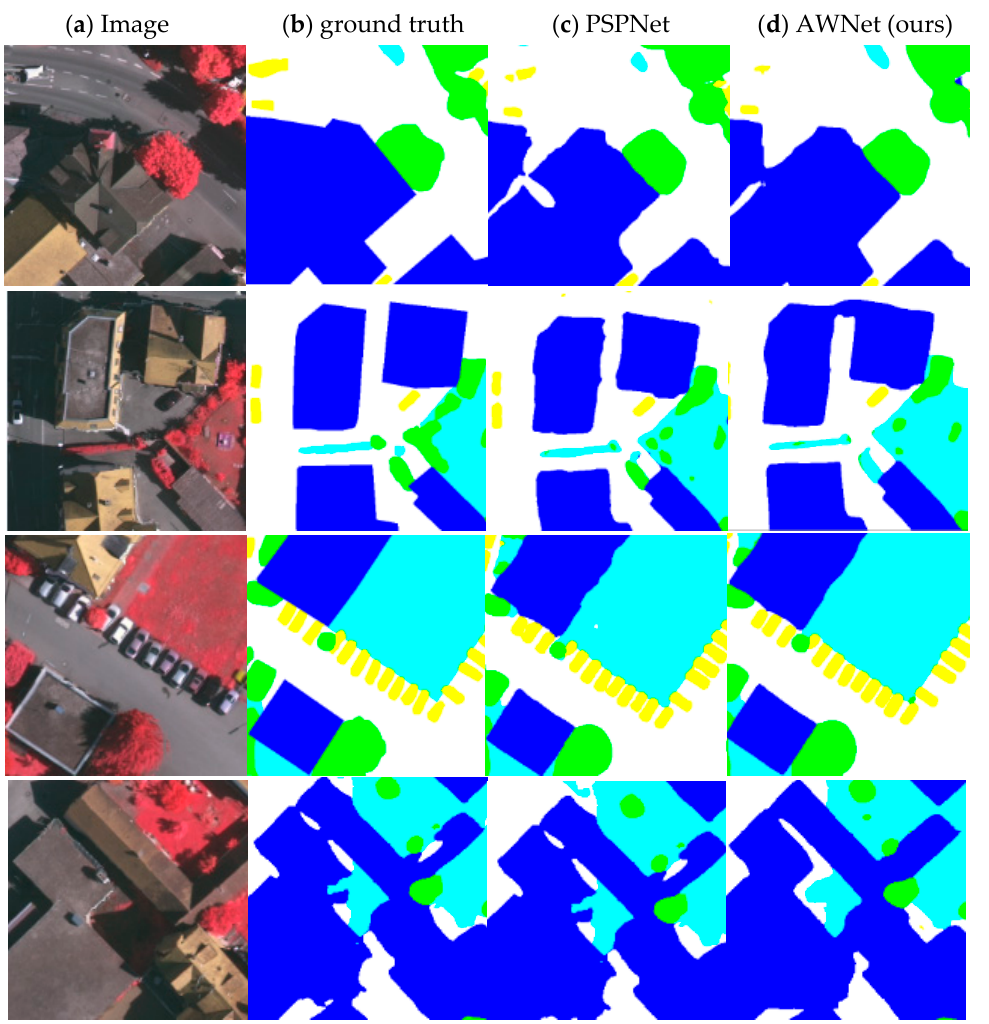
Figure 11. The edge prediction output of our model and Pyramid Scene Parsing Network (PSPNet). Vaihingen’s label includes six categories: impervious surface (white), building (blue), low vegetation (cyan), tree (green), car (yellow), and chaos/background (red). ( a ) Input image. ( b ) Ground Truth. ( c ) A partial enlarged view of the PSPNet segmentation result. ( d ) A partial enlarged view of our proposed AWNet segmentation result.